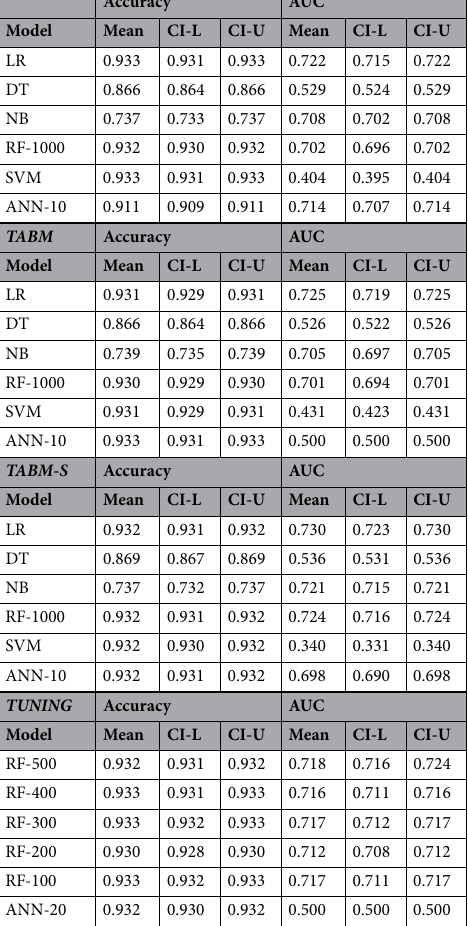
Table 3. Model performance for predicting necrotizing enterocolitis: Means and confidence intervals over 50 runs. Abbreviations: ANN Artificial neural network, AUC Area under the receiver-operating-characteristic curve, CI-L Lower bound of 95% confidence interval, CI-U Upper bound of 95% confidence interval, DT Decision tree, LR Logistic regression, NB Naïve Bayes, RF Random forest, SVM Support vector machine, TABM 3 variables (ambient temperature average, minimum and maximum for birth month in Table 2) included, TABM-S 4 variables (ambient temperature average, minimum and maximum for birth month as well as sepsis in Table 2) included, TUNING The hyper-parameters of random forest and the artificial neural network are tuned for TABM-S (e.g., RF-500 and ANN-20 represent the random forest with 500 trees and the artificial neural network with two hidden layers of the size 20,